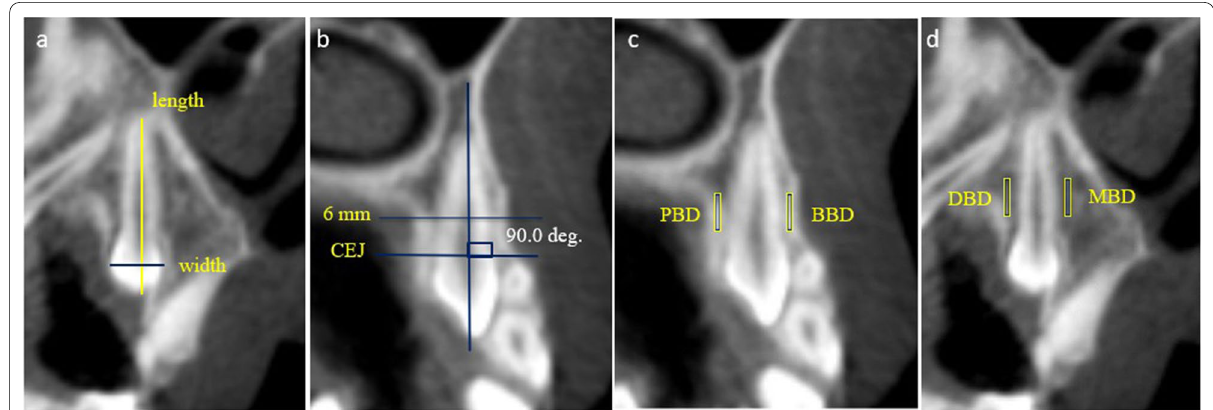
Fig. 4 a The quantitative dental measurements including length and width of canines; b Measurement of bone density around the impacted canine between the CEJ line’s midpoint and the root apex. c , d Measurement of the bone density at each surface mesially, distally, facially, and palatally